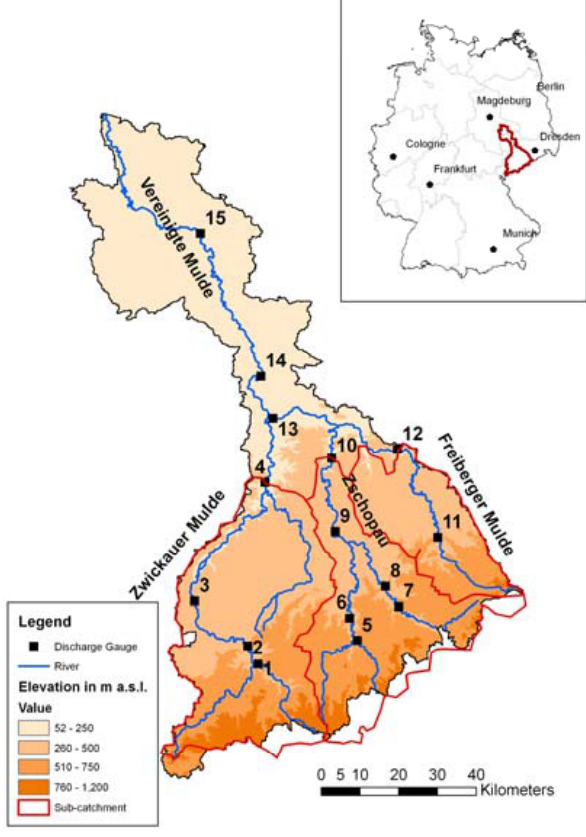
Fig. 1. Study area Mulde catchment: left: discharge gauge locations (numbered according to Table 1) and the digital elevation model; right: geographical location in Germany